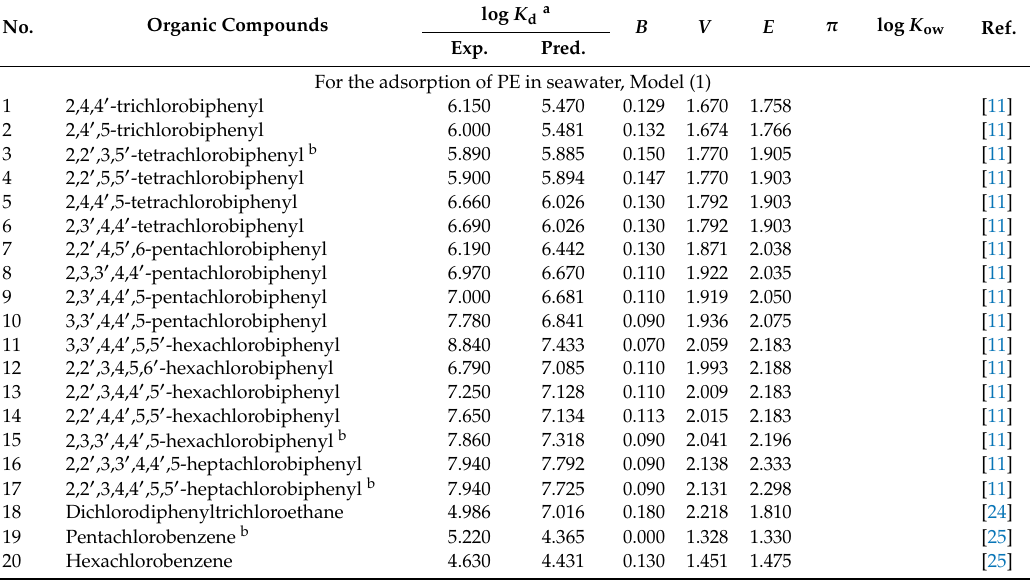
Table 2. Experimental and predicted log K d values of organic compounds and the values of selected molecular descriptors in Models (1), (2), (4), (5), and